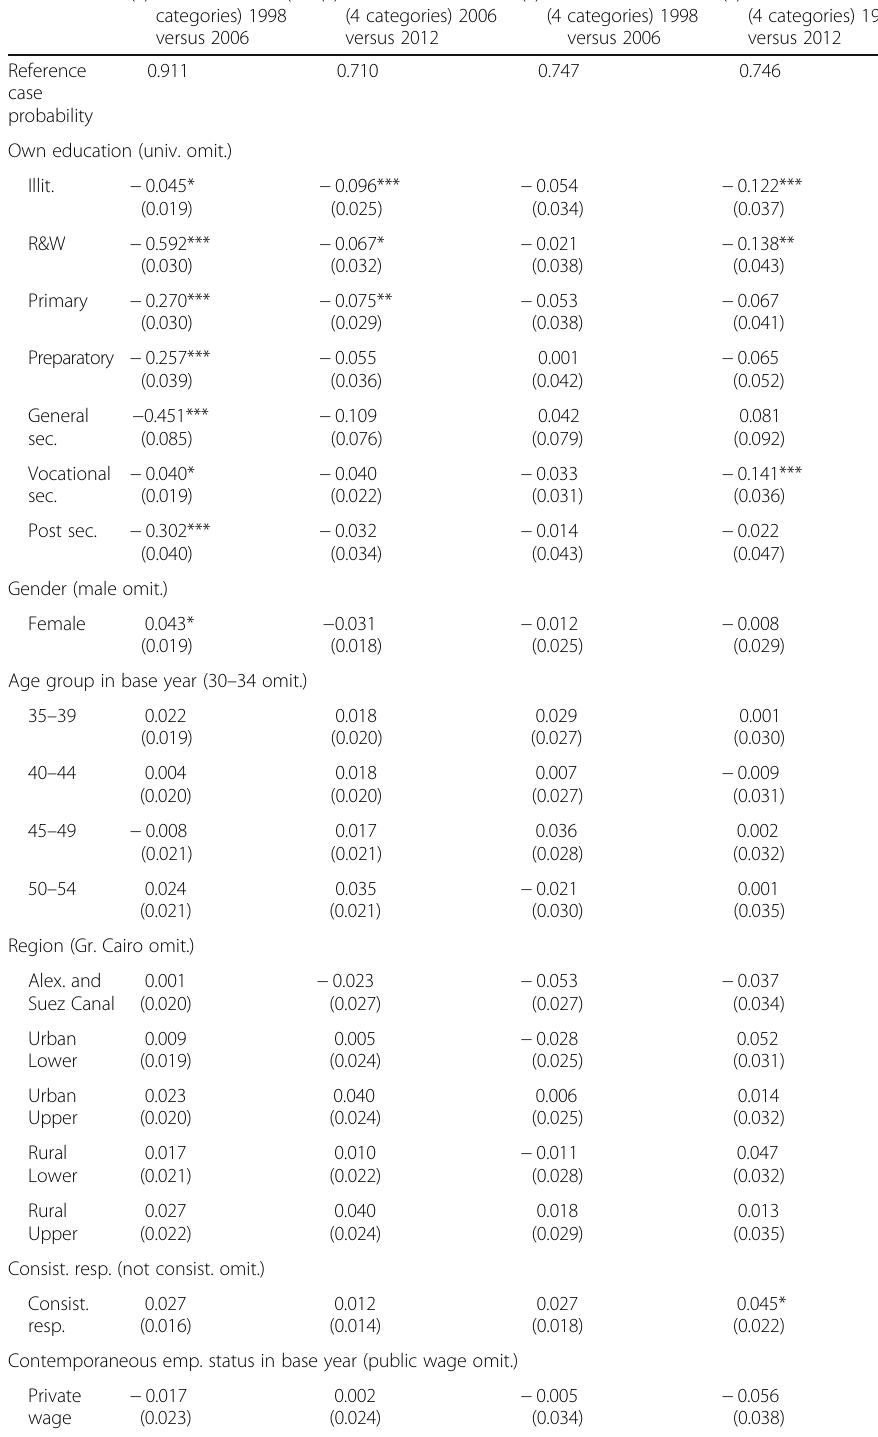
Table 2 Probit model marginal effects for the probability of alignment of reporting own education and father ’ s employment sector and status between the three contemporaneous points (1998, 2006, and 2012), individuals in base year (1998 or 2006) and present in the other waves, aged 30 – 54 in